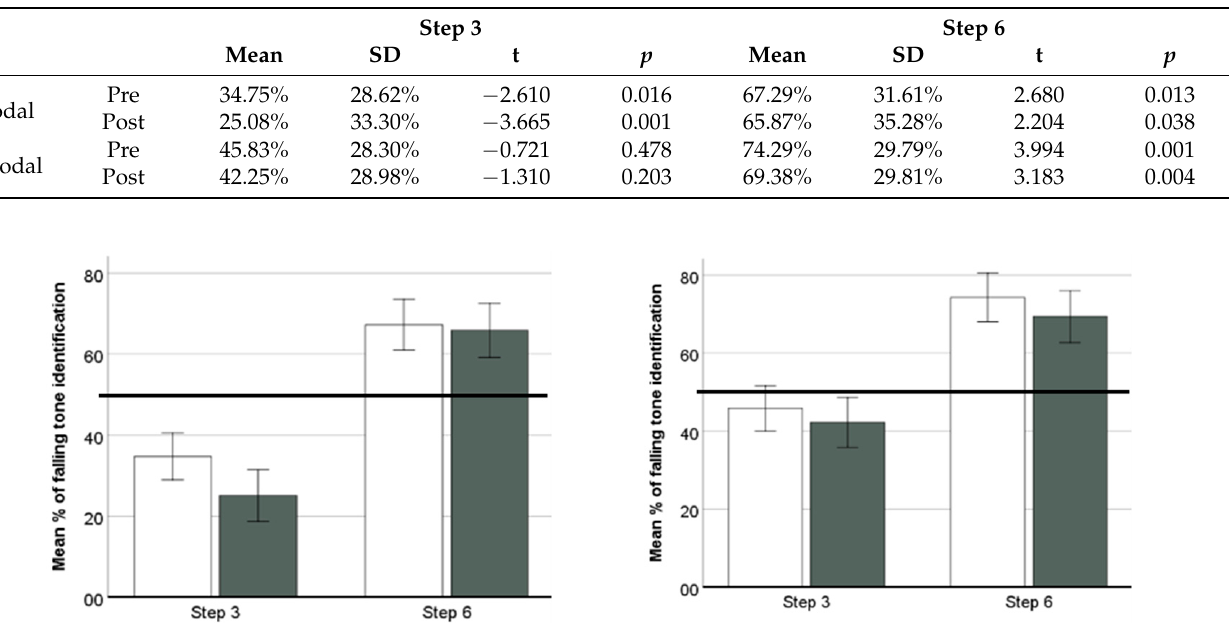
Table 2. Mean (SD) percentage of choosing falling over flat tones in bimodal and unimodal before and after distributional learning in the identification task. (See Supplementary Material D for descriptive statistics of other contrasts.).